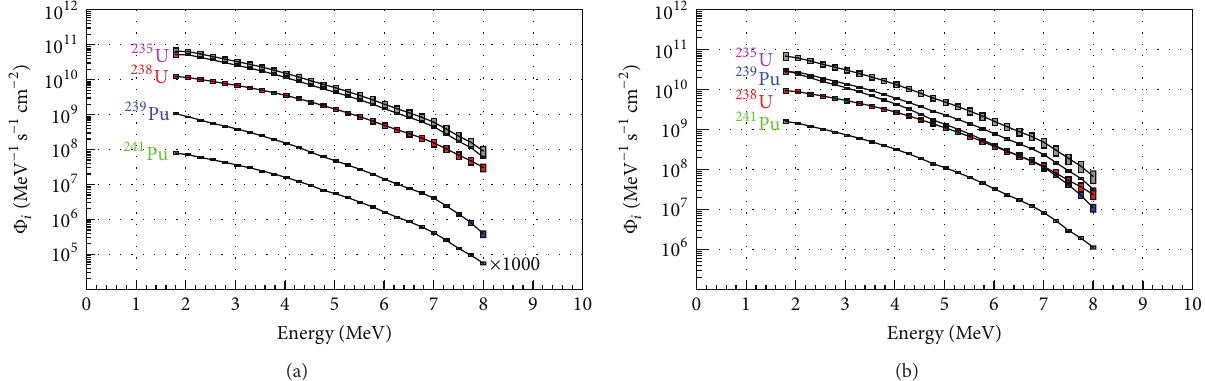
Figure 6: Antineutrino flux produced by the fission of the 4 main fissile isotopes at 100 meters from one of the LVNPP reactors of 2.027 GWth at days 5 (a) and 200 (b) of operation. The gray curve (a) is the total flux.